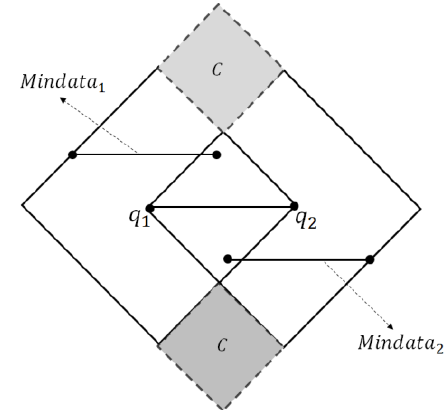
Figure 5. Critical regions with respect to and